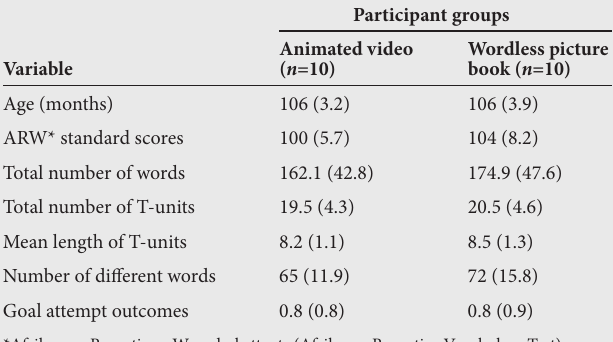
Table 1. Means (and standard deviations) for the different variables for participants in the wordless picture book and animated video